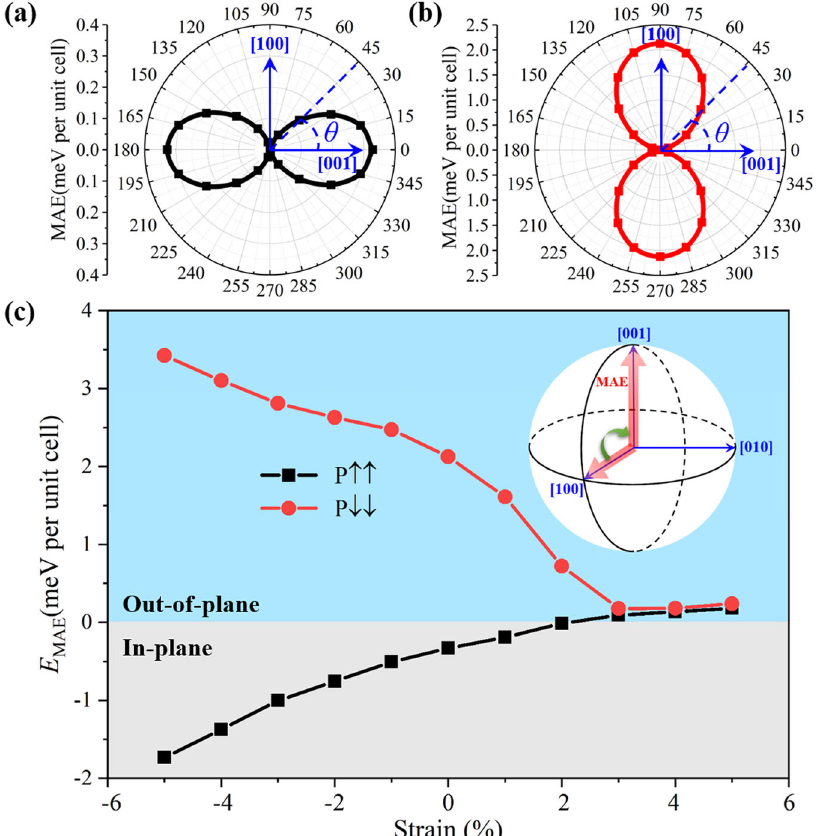
Fig. 4 MAE of bi-NiI 2 /bi-In 2 Se 3 heterostructure. a , b Polar angle θ dependence of MAE with a – c plane for P ↑↑ and P ↓↓ cases, respectively. c Variation of E MAE as a function of biaxial strain for P ↑↑ and P ↓↓